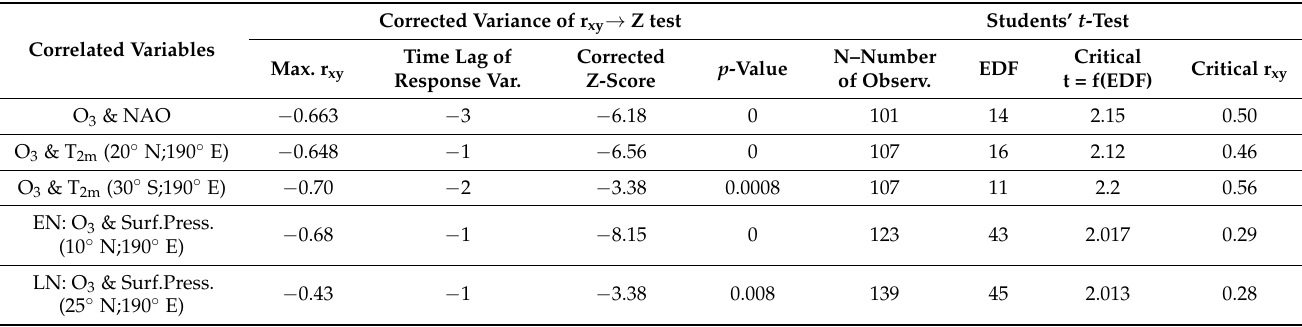
Table 1. Values of maximal lagged correlation coefficients at some regions with well-defined covari- ance between studied variables, their p -values and critical correlations, calculated by two methods (Z-test and t -test) after accounting for the autocorrelation of analyzed time